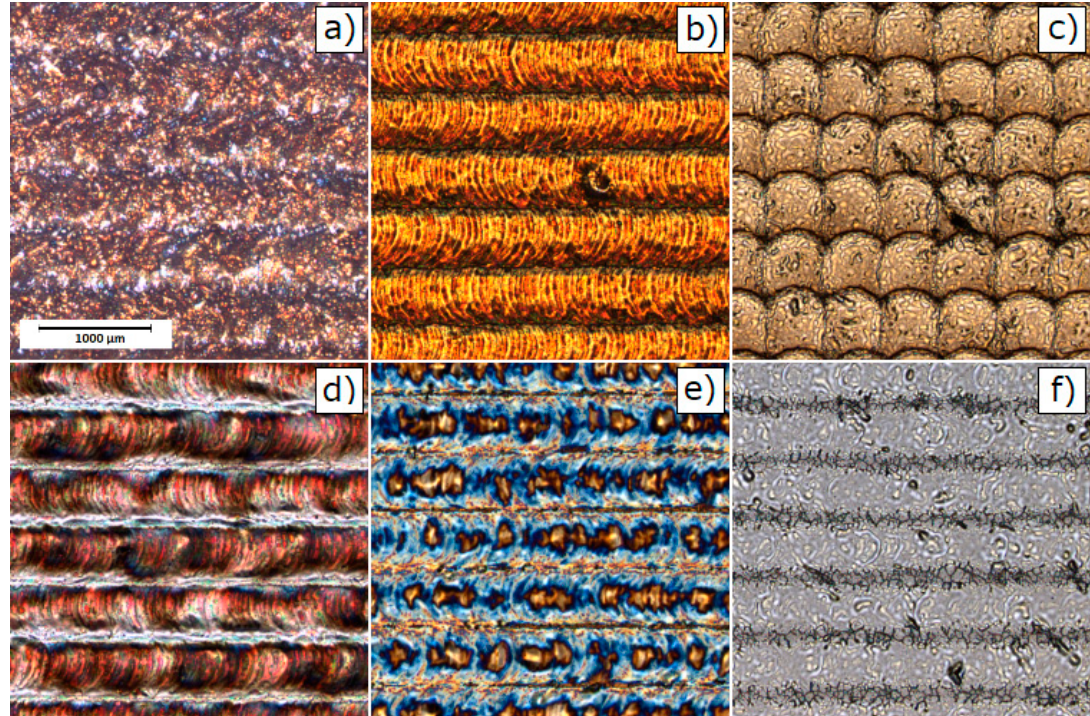
Figure 3. The AISI 316 COM images of surfaces treated with di ff erent laser marking parameters (i.e., scanning speed, pulse repetition rate) recorded for: ( a ) 316_20_10; ( b ) 316_20_100; ( c ) 316_20_1000; ( d ) 316_80_10; ( e ) 316_80_100; and ( f ) 316_80_1000 samples (naming of samples see: Table